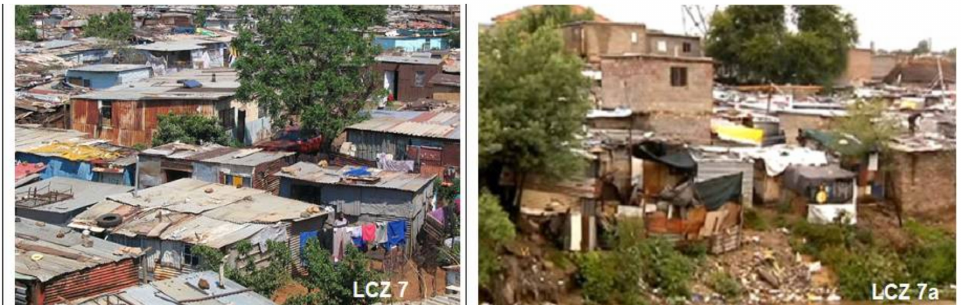
Figure 7. East London squatter camp types; LCZ 7 showing a standard lightweight region while LCZ 7a shows a hybrid region of concrete and light